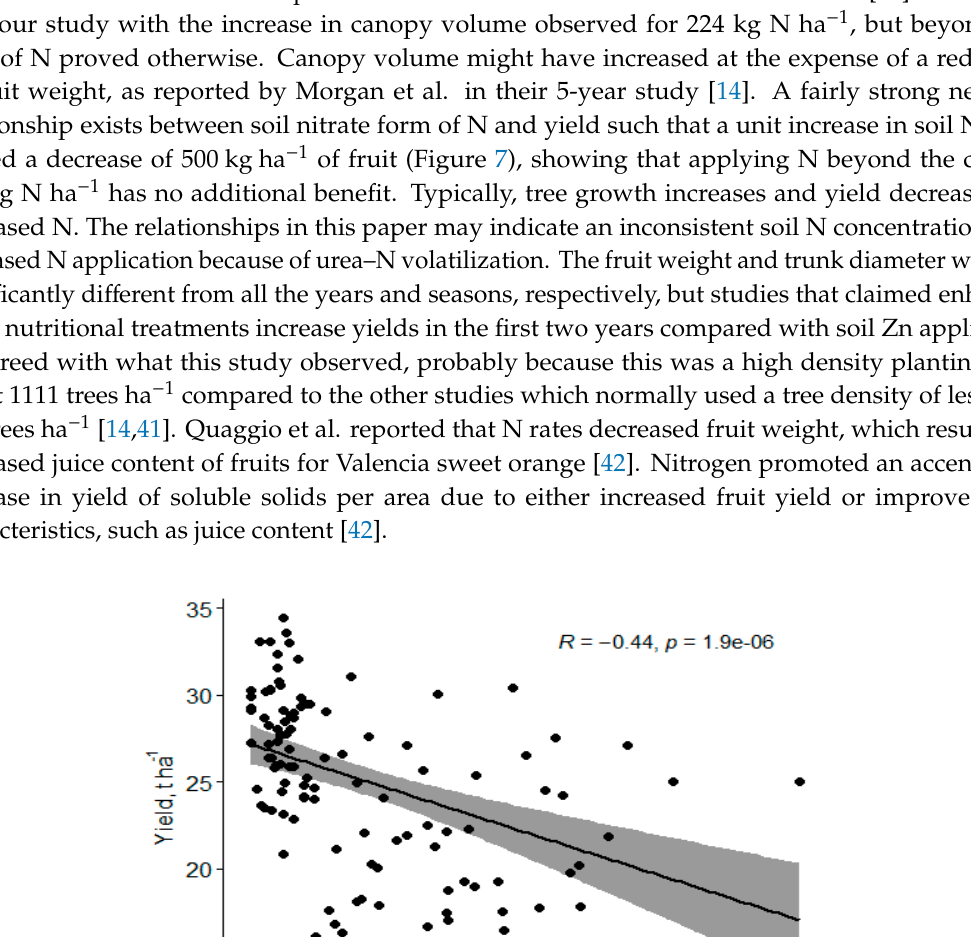
Figure 7. Negative correlation of soil NO −